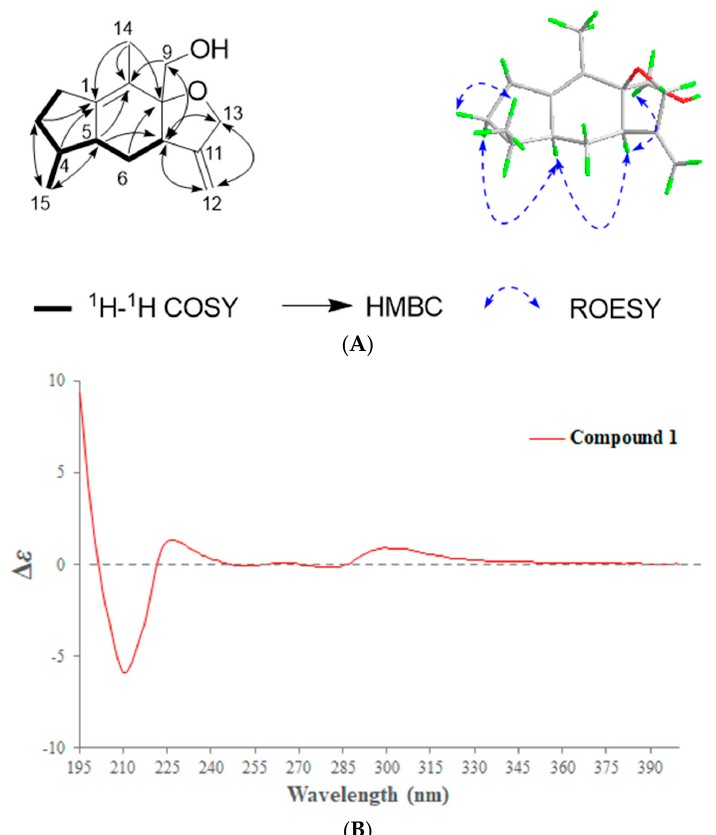
Figure 1. ( A ) The key 2D NMR correlations of compound 1 . ( B ) ECD spectrum of compound 1 .